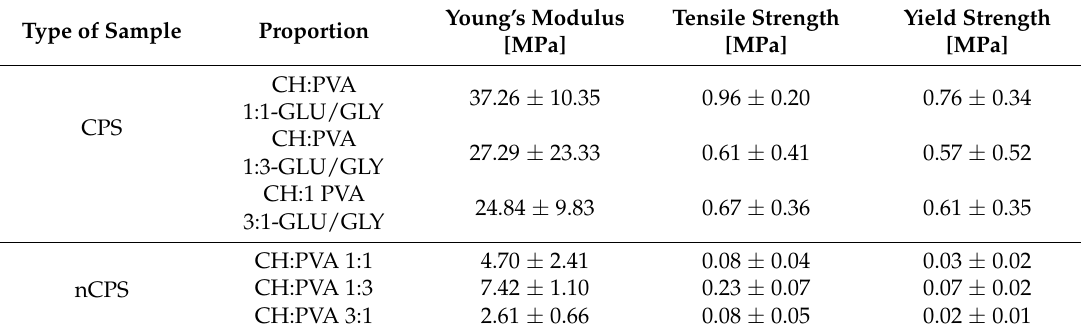
Table 2. Mechanical properties for the prepared scaffolds. Type of